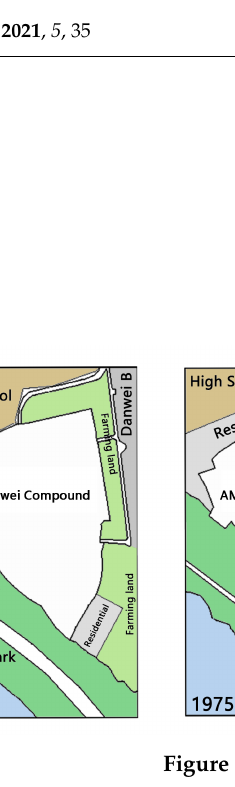
Figure 6. Boundary of the AMS Danwei compound and surrounding land usage.